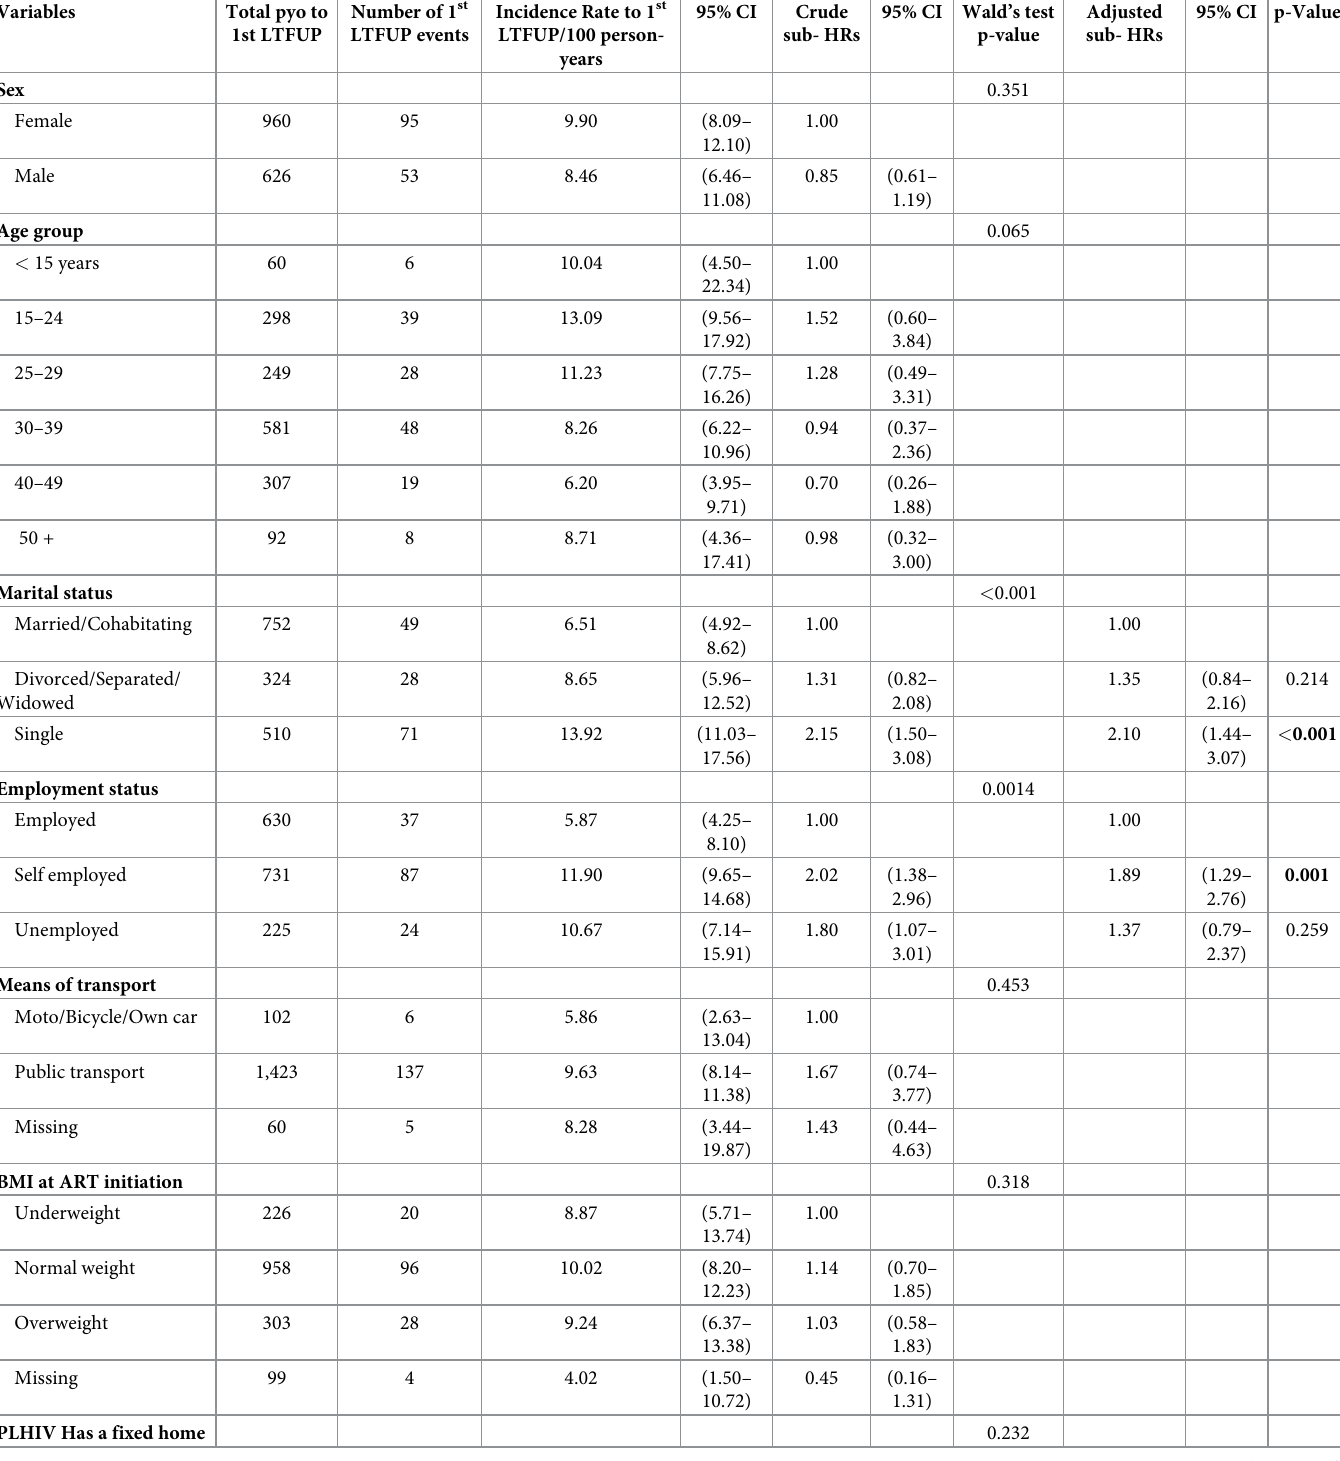
Table 2. Using Fine-Gray’s competing risk regression models to determine factors associated with time to first LTFUP event among PLHIV who initiated ART in 2018, Nyarugenge district, Kigali